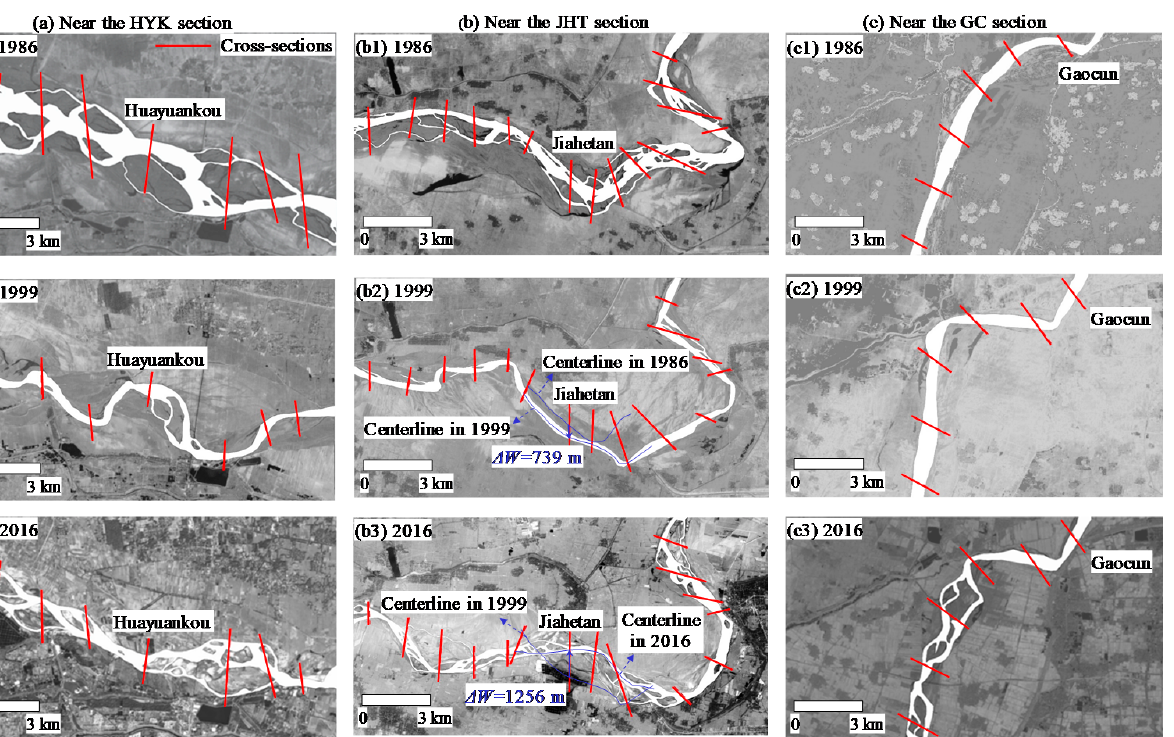
Figure 4. Cumulative volume of bed deformation in the braided reach and the LYR during the period 1986–2016.